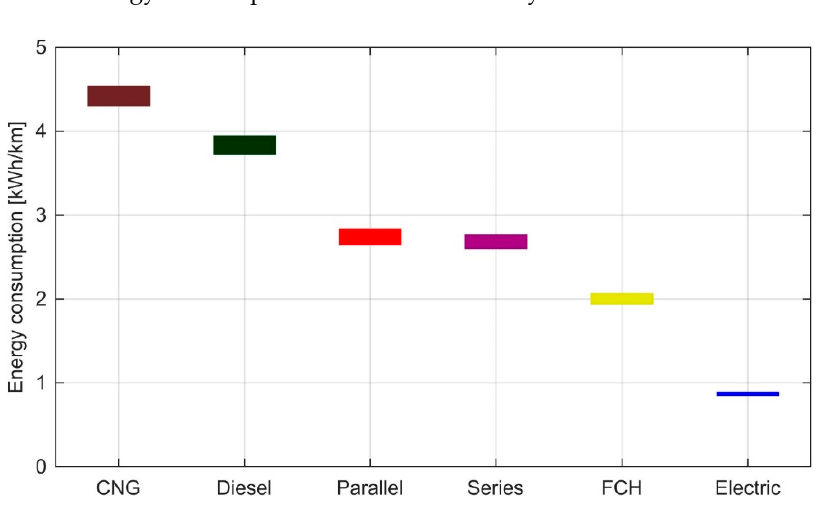
Figure 10. Energy consumption on the BR cycle without load and with a 1000 kg load.